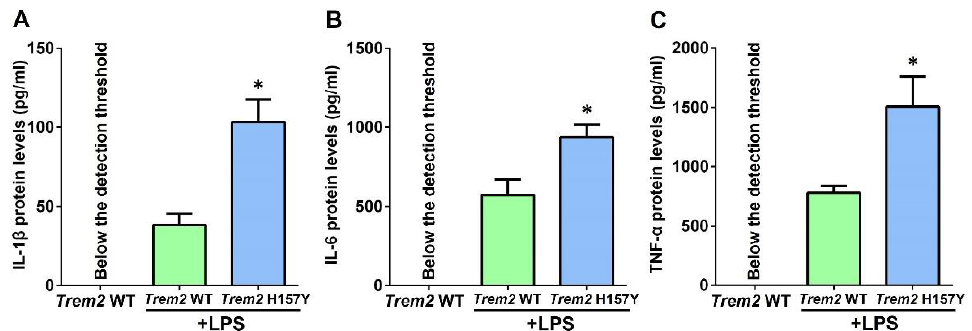
Figure 3. The Trem2 H157Y variant facilitates microglial release of inflammatory cytokines. ( A – C ) Levels of the inflammatory cytokines IL-1 β , IL-6, and TNF- α in WT Trem2 BV2 microglia and BV2 microglia with the Trem2 H157Y variant were detected by ELISA. Data were analyzed using the Student’s t -test. Columns represent means ± SDs (n = 3, performed in triplicates). * p < 0.05 versus LPS-stimulated WT Trem2 BV2 microglia.